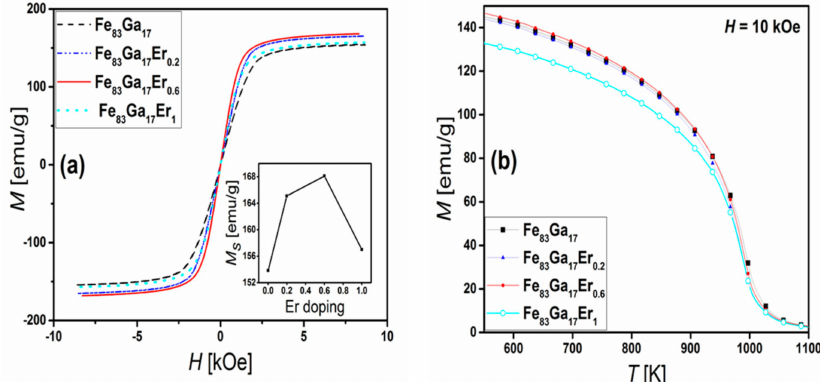
Figure 5. ( a ) Magnetization hysteresis loops of Fe 83 Ga 17 Er x ( x = 0, 0.2, 0.6, 1). The inset shows the saturation moment as a function of the Er doping amount; ( b ) Magnetization (emu/g) of (Fe 0.83 Ga 0.17 ) 100 − x Er x at H = 10 k Oe as a function of temperature for different amounts of Er